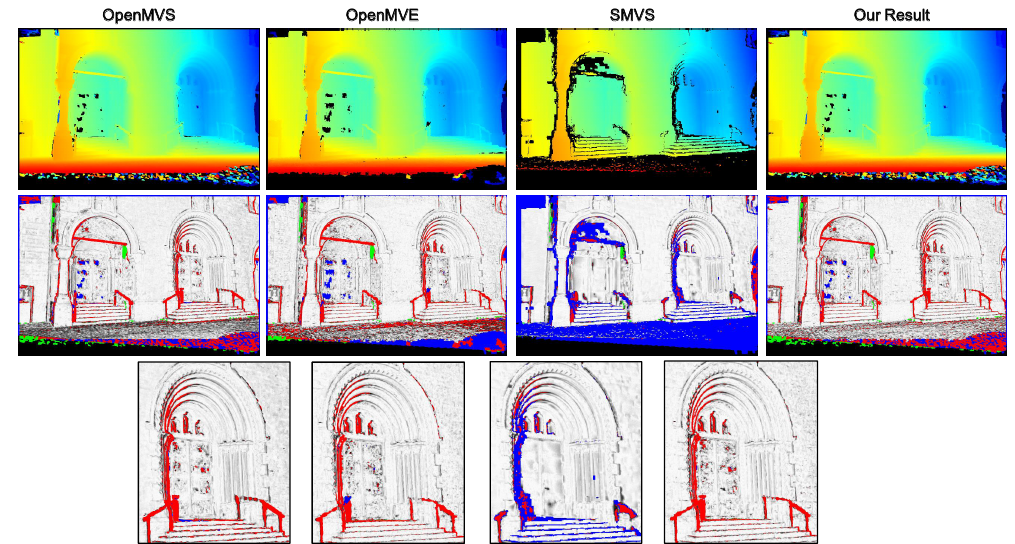
Figure 11. Colorized depth maps and visualized (relative) depth errors on Herz-Jesu-P11